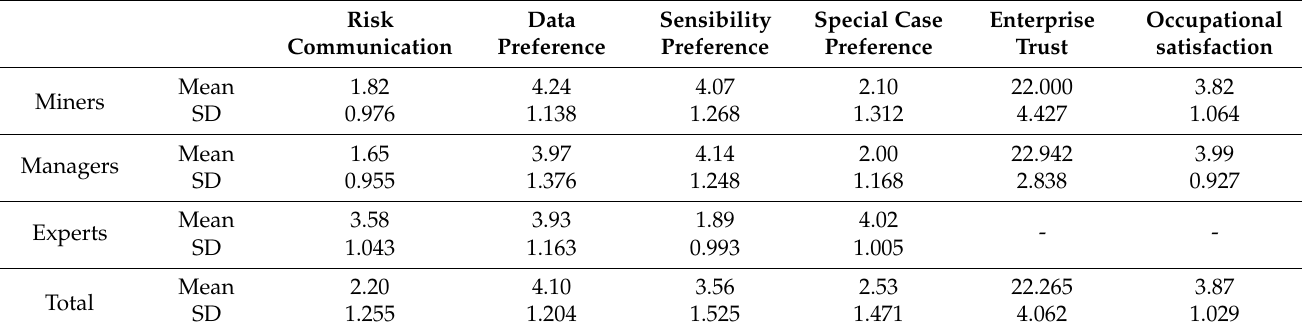
Table 4. Characteristics of different groups of